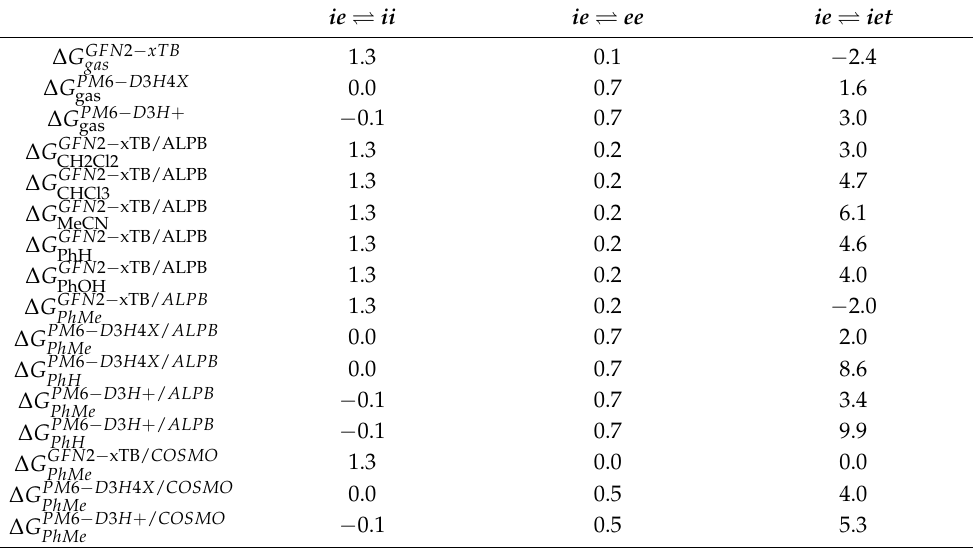
Table 3. Gibbs free energies for the interconversion between different conformers and the species ie in gas phase (for reference) and in toluene at 300 K. All energies are given in